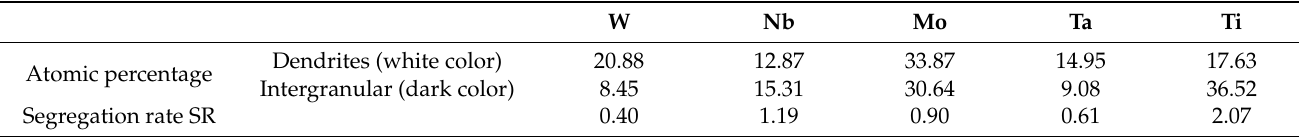
Figure 4. Area-scan distributions of elements in WNbMoTaTi layer. Table 1. Chemical composition of WNbMoTaTi HEAs layer (at%).